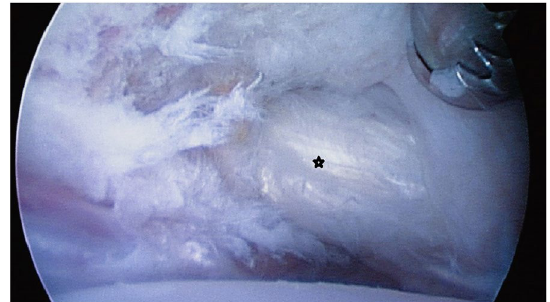
Fig. 2 Arthroscopic image of the hip joint. Arthroscopic image in a case of IPI after a total hip arthroplasty. Notice the mildly frayed psoas tendon